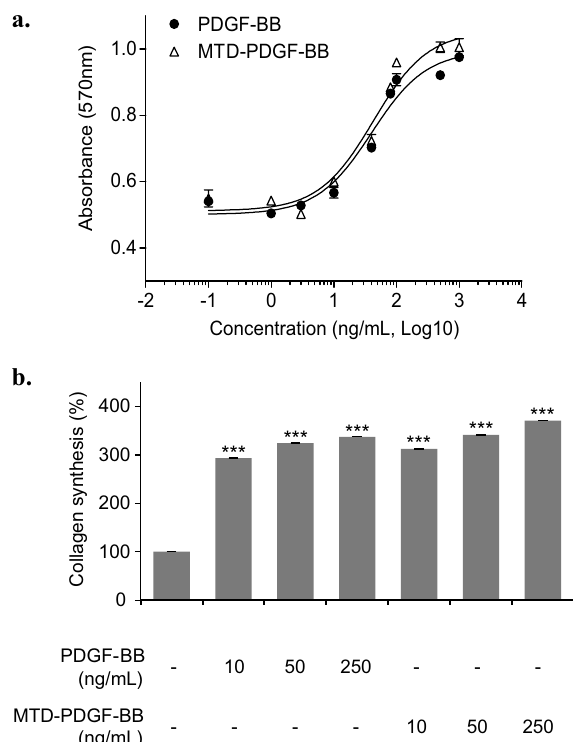
Figure 5. Biological activity of PDGF-BB and MTD-PDGF-BB. ( a ) Cell proliferation activity of PDGF-BB and MTD-PDGF-BB using fibroblast cell line NIH 3T3 cell. Cell proliferation activity in NIH 3T3 cells was analyzed by measuring the color development using MTT. All data are expressed as mean ± standard deviation based on triplicates of at least two independent experiments. ( b ) Collagen synthesis effect of PDGF-BB and MTD-PDGF-BB. The amount of collagen in the HDFa culture supernatant was measured using a procollagen type I C-peptide (PIP) EIA kit. Data are expressed as mean ± S.E. based on triplicates of at least two independent experiments. Asterisks indicate statistical significance compared with the cell culture without treatment of PDGF-BB and MTD-PDGF-BB, as determined by the student’s t-test (*p < 0.05, **p < 0.01, ***p <